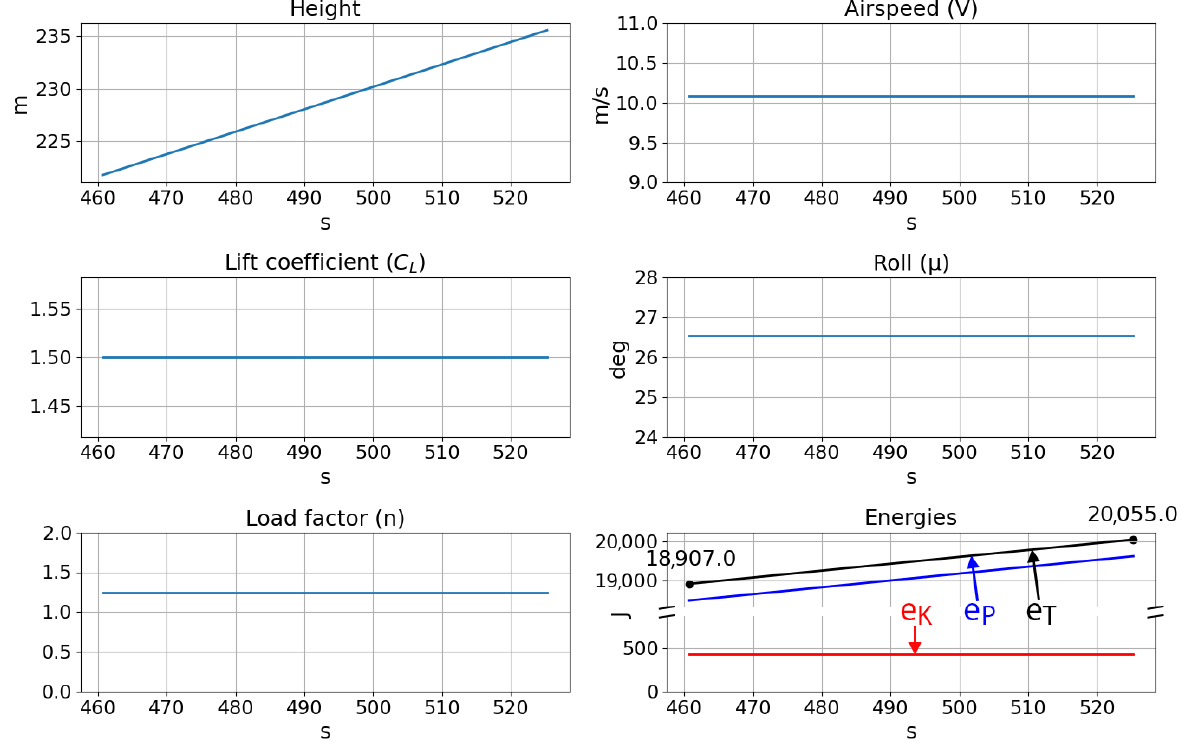
Figure 21. Trajectory trace of the thermal soaring SUAV